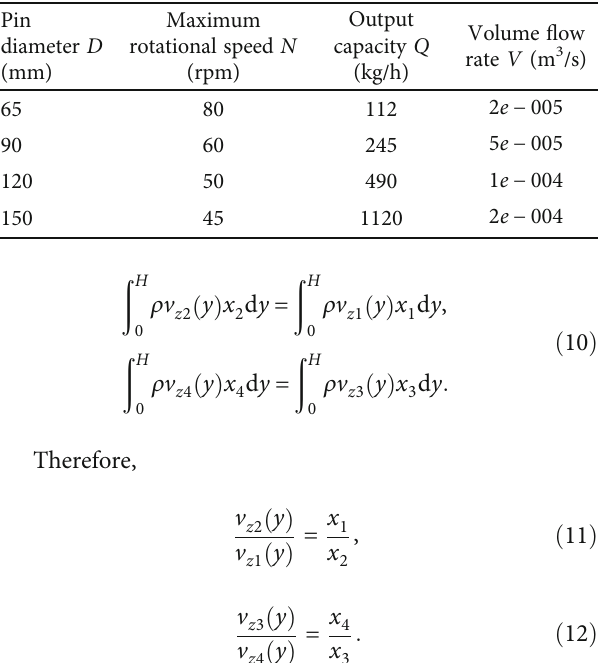
Figure 5: Three-dimensional model of partial pin barrel segment.